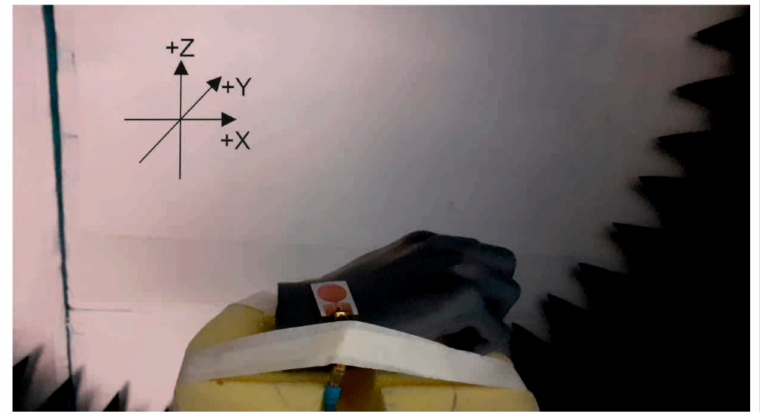
Figure 4. Flexible antenna on the hand phantom in